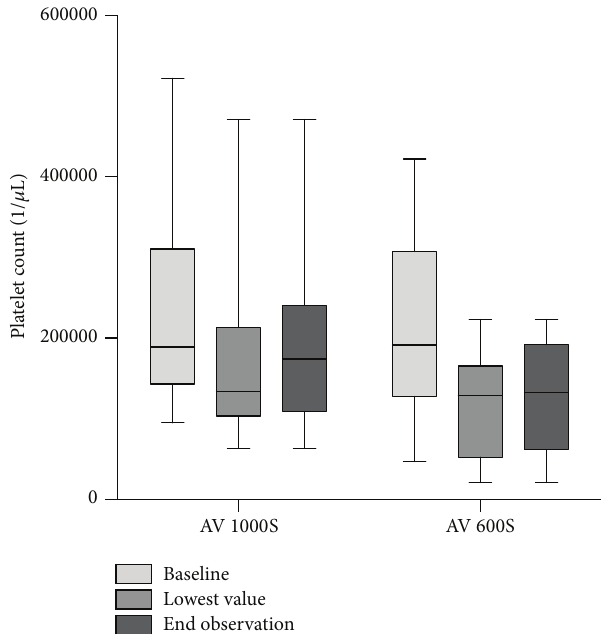
Figure 2: Changes in platelet counts with